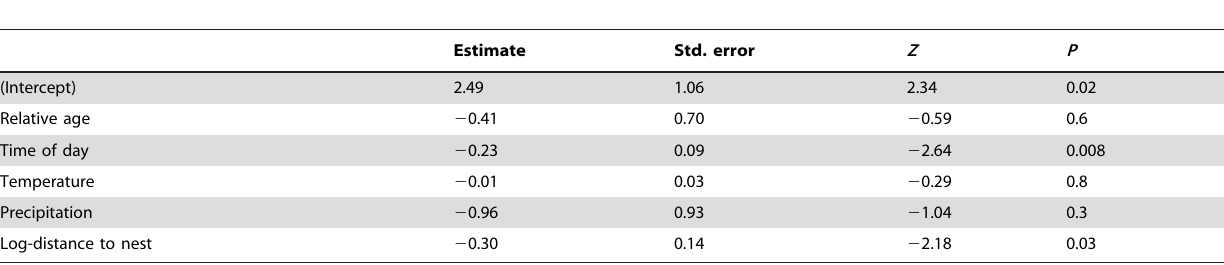
Table 7. Relationship between probability of observing food provisioning, age of nestlings, time of the day, temperature, hourly precipitation and distance of parent to nest in 2010 at Foreˆt Montmorency (Que´bec, Canada); Pearson correlation coefficient between observed and fitted frequencies: r =0.20 ( n =16 nests).